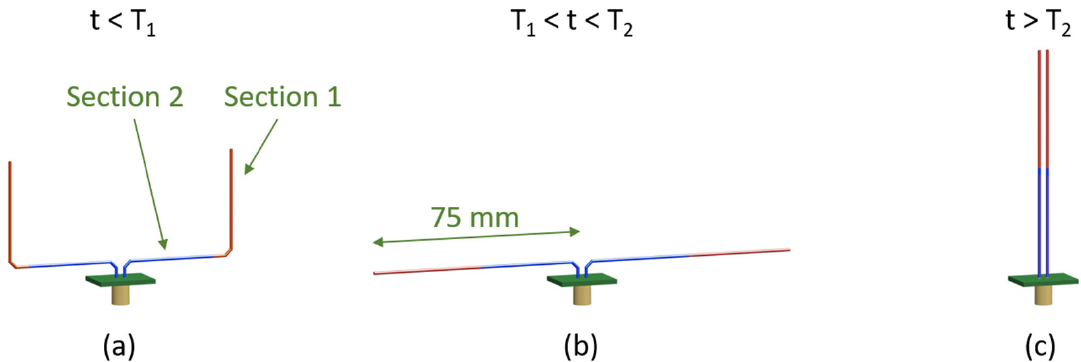
Figure 2. ShMoA under different temperature regions. Section 1 has a threshold temperature at T 1 ; Section 2 has a threshold temperature at T 2 . ( a ) Temperature below both thresholds, ( b ) temperature crossing the first threshold, and ( c ) temperature crossing the second threshold.